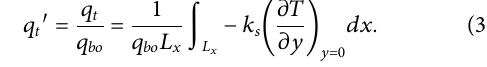
Frontiers in Energy Research |